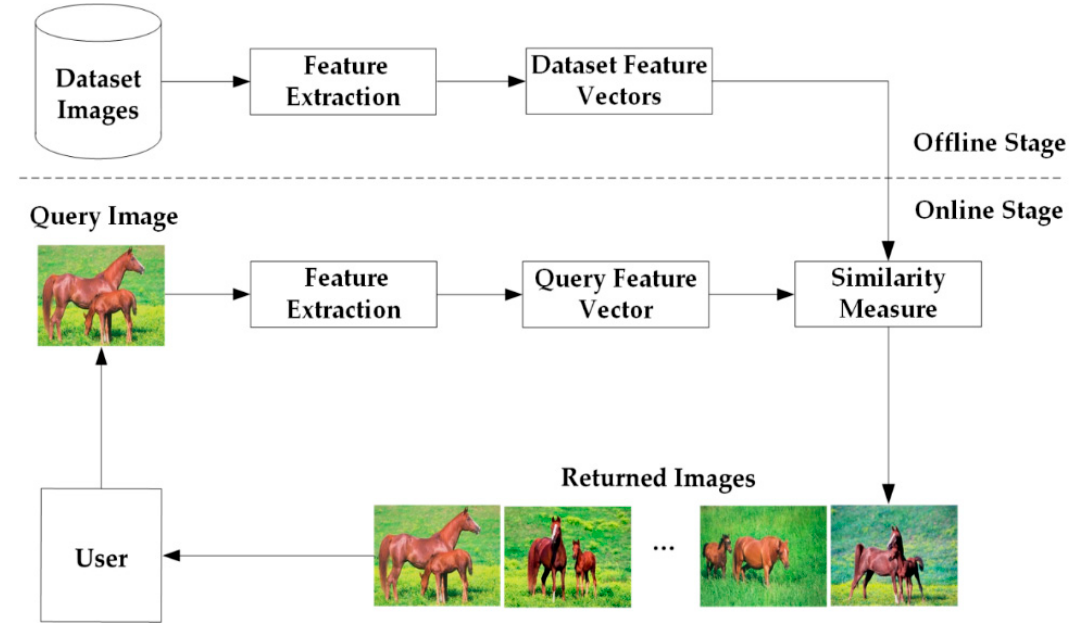
Figure 5. Schematic diagram of the proposed retrieval system.